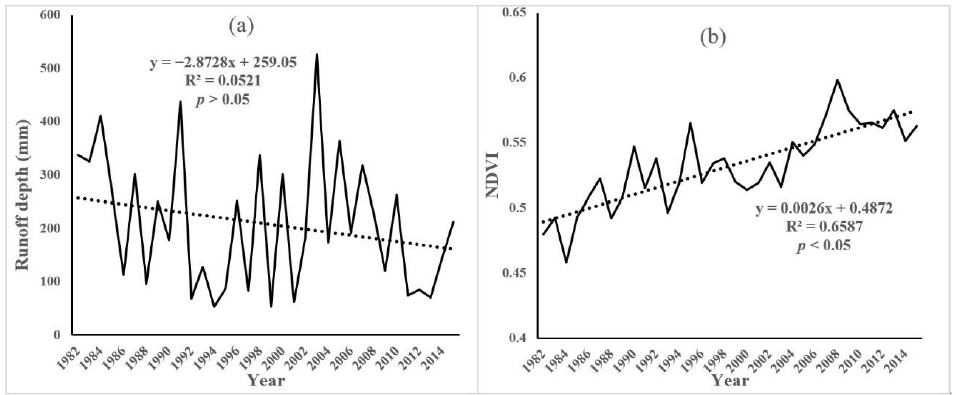
Figure 2. Annual variation tendencies of the runoff depth ( a ) and NDVI ( b ) values in in MUHR. Figure 3-a reveals the change tendencies for annual precipitation and potential evaporation from 1982 to 2015 in the MUHR. The annual rainfall shows a fluctuating and non-significant downward trend and its interannual change is dramatic, with a gradient of −1.17 3 mm/a ( p > 0.05). During the study period, the annual average precipitation in the MUHR ranged from 600 to 1300 mm. The average annual potential evaporation in the MUHR were in the ranges of 950 – 1750, with a non-significant upward trend ( p > 0.05) and a gradient of 0.0147 mm/a. Figure 3-b reveals the change tendencies for actual evaporation from 1982 to 2015 in the MUHR. The actual evaporation show a non-significant upward trend ( p > 0.05), with gradients of 1.6998 mm/a. During the study period, the average actual evaporation in the MUHR were in the ranges of 550 – 850 mm.